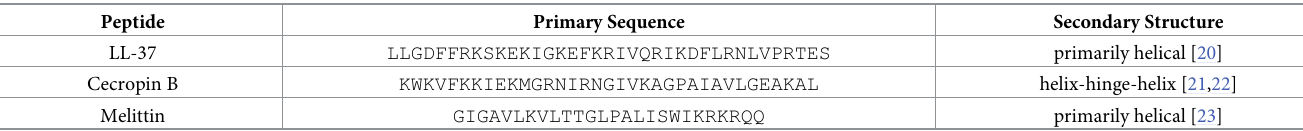
Table 1. Structures of antimicrobial